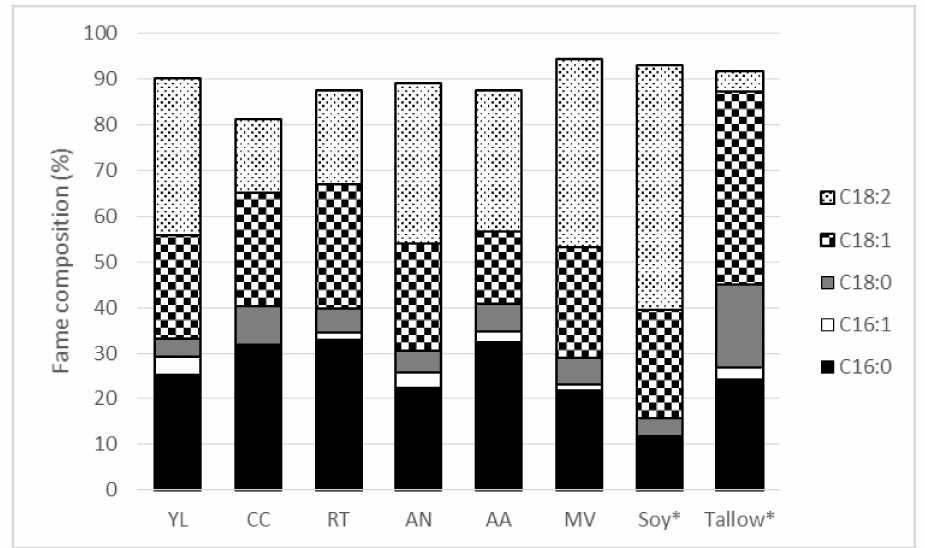
Figure 2. Fatty acid methyl ester (FAME) composition of the oils from six selected strains grown on pure DSW and comparison with other oil feedstock for biodiesel. YL: Yarrowia lipolytica ; CC: Candida curvata ; RT: Rhodosporidium toruloides ; AN: Aspergillus niger ; AA: Aspergillus awamori ; MV: Mortierella vinacea . * Data from